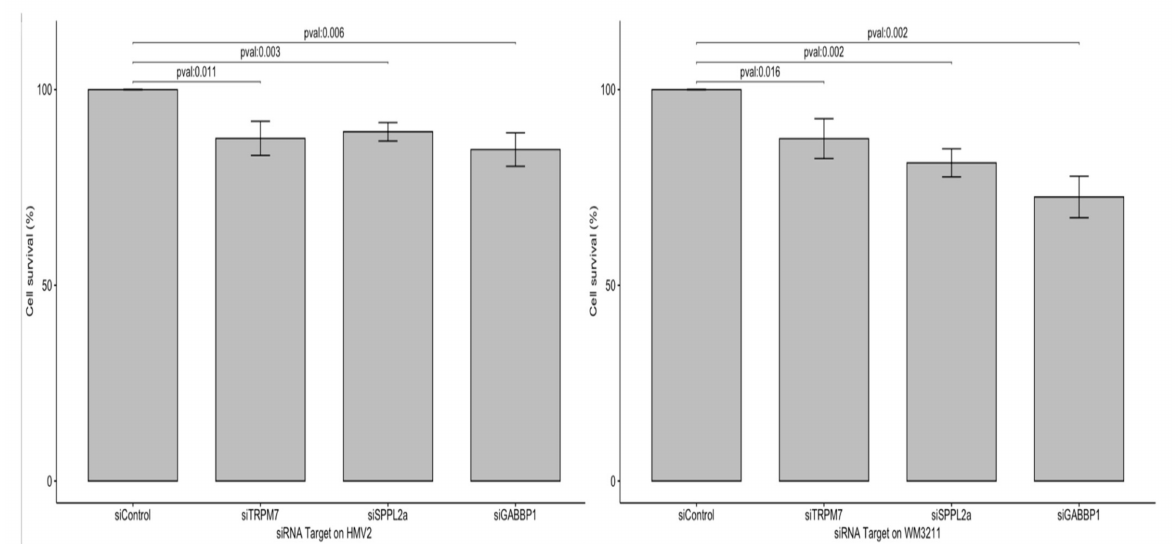
Figure A8. Cell proliferation assay on two human non-UV induced melanoma cell lines (HMV2 and WM3211) showing the effect of the knockdown (siRNA) of TRPM7, GABPB1 and SPPL2A genes on cell